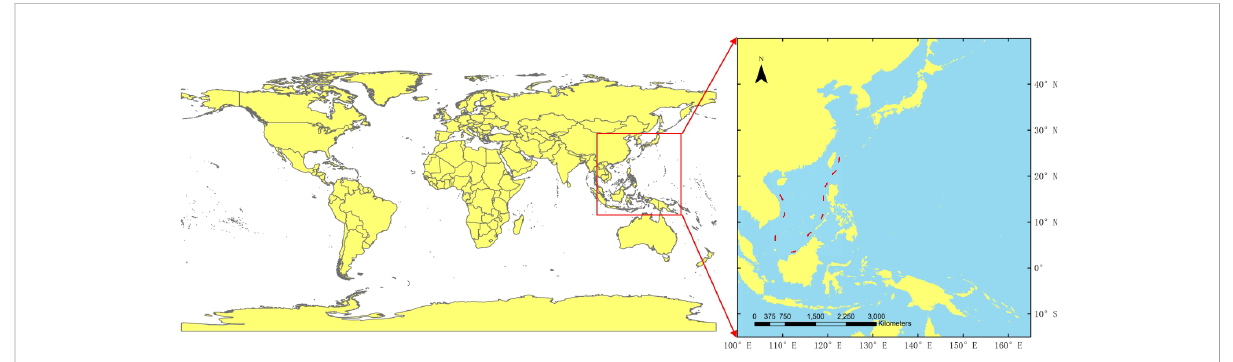
FIGURE 2 Research area map. Part of the Northwest Paci fi c (15°S – 50°N, 100°E –